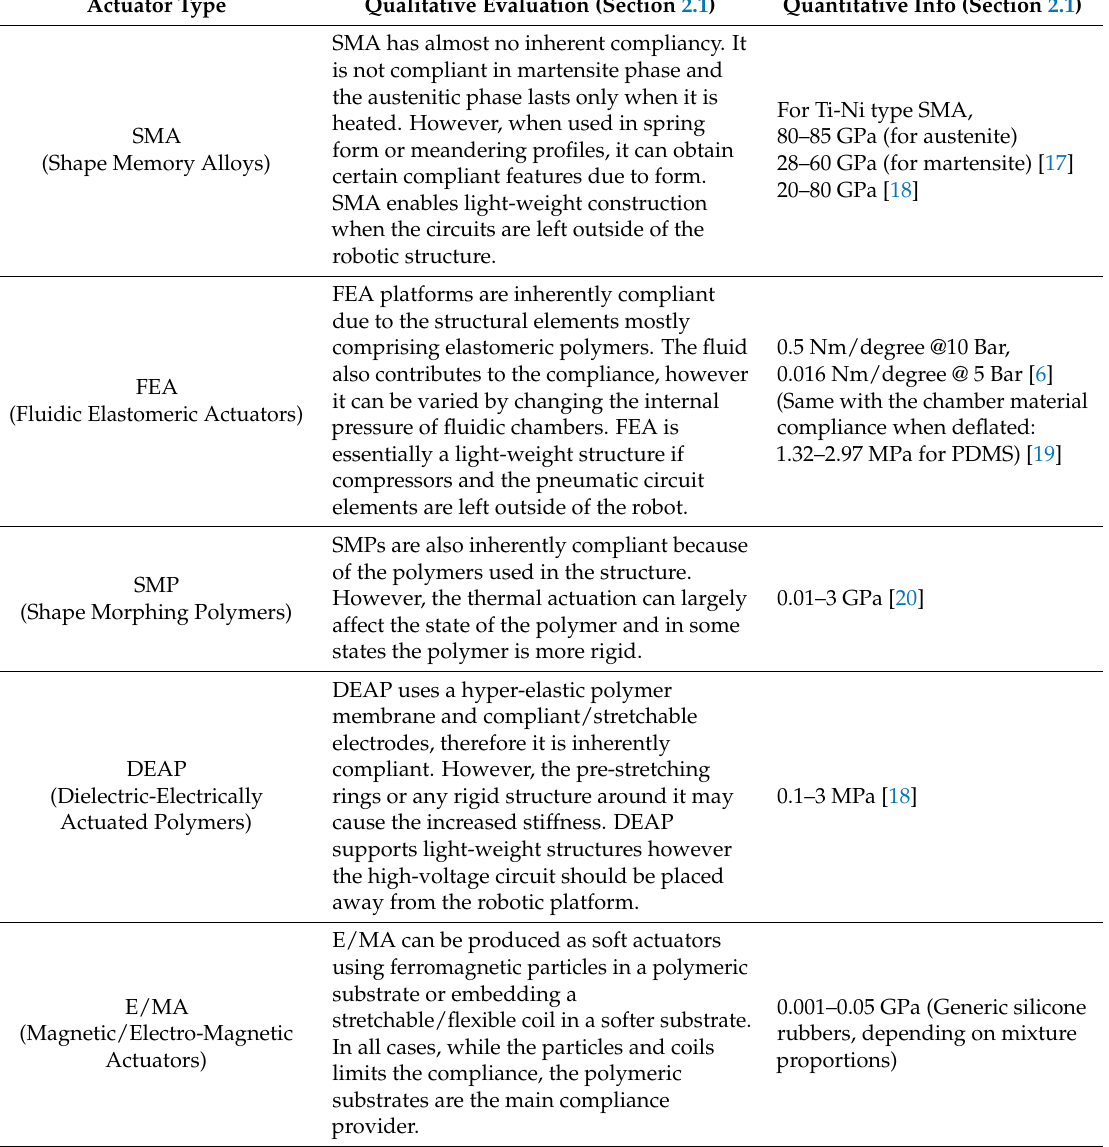
Table 2. Evaluation of soft/novel actuators according to compliance criteria (Section